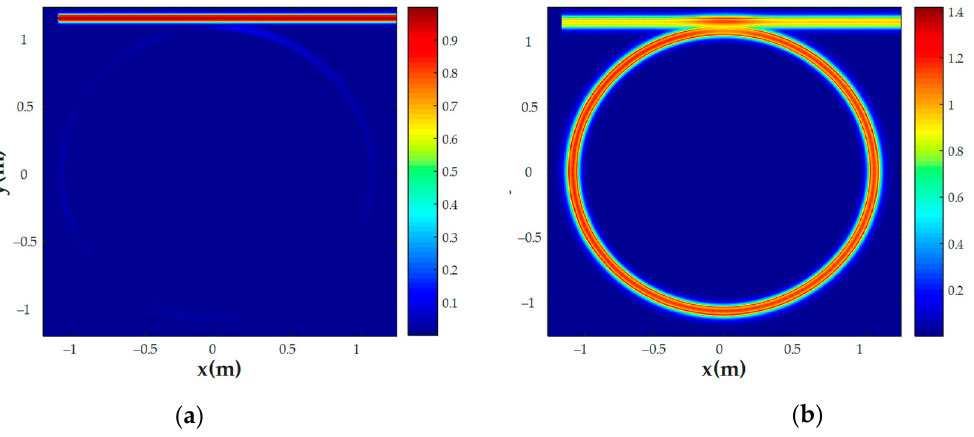
Figure 8. E-field distribution of the CCl 4 sensor at ( a ) a non-resonant wavelength (1532.39 nm) and ( b ) a resonant wavelength (1543.2 nm). Table 4. All-pass sensor characteristics for different gases.